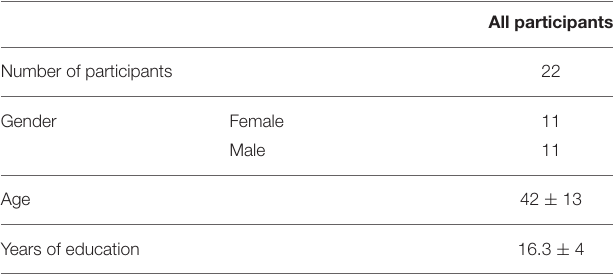
TABLE 1 | Patient baseline characteristics.